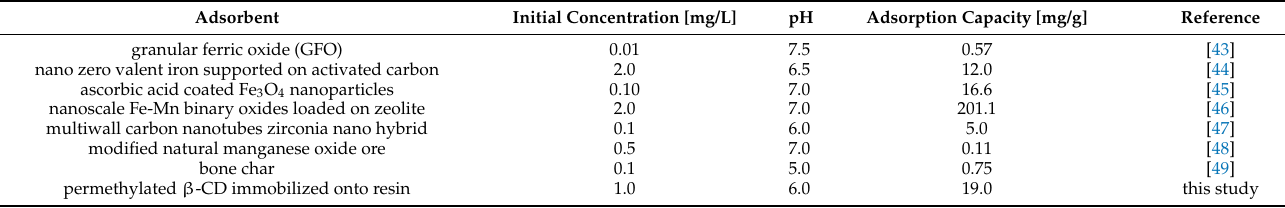
Table 2. Comparison of equilibrium uptake capacity ( q e ) of different adsorbents for As(V) ions.